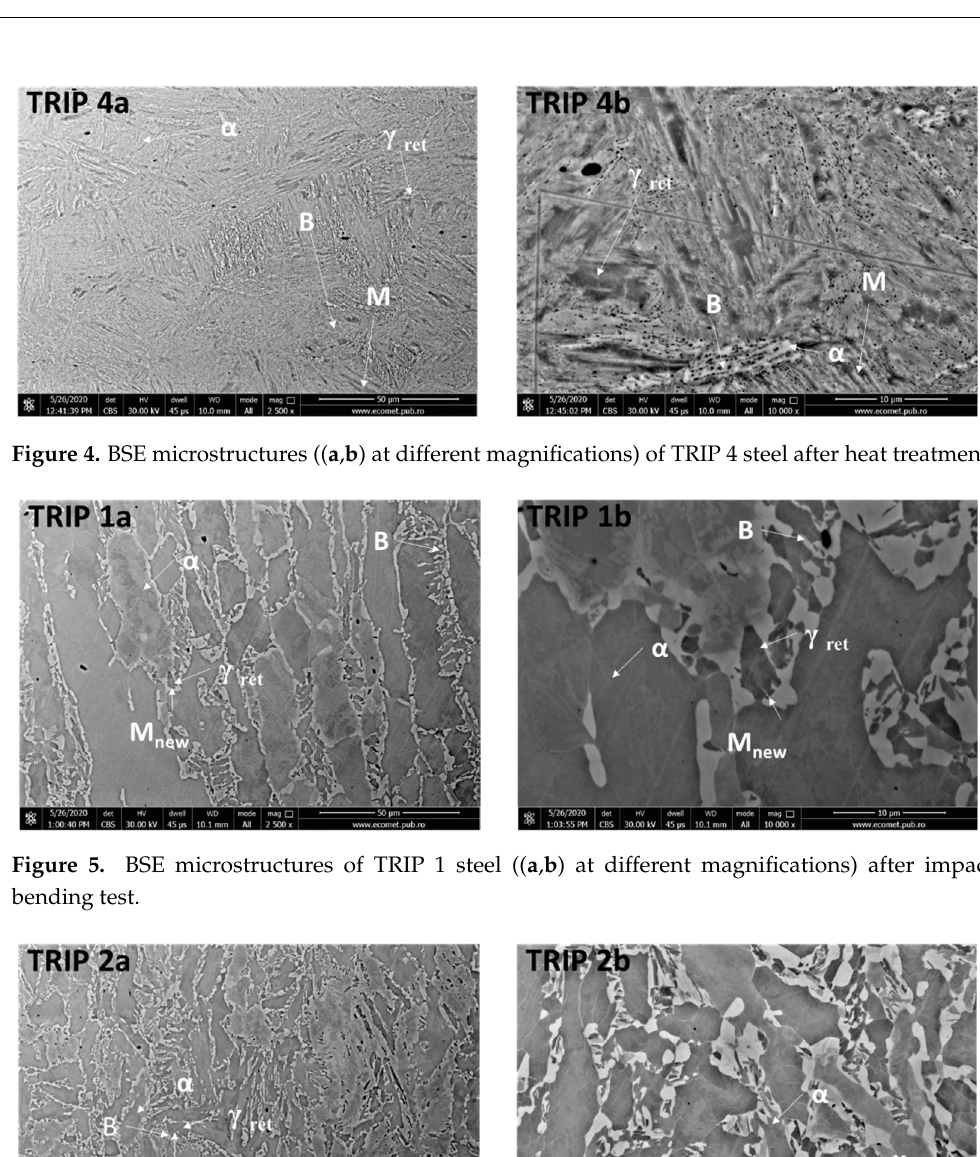
Figure 3. Microstructures (BSE—( a ); SE—( b )) of TRIP 3 after heat treatment.